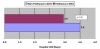
Adjusted least squares mean hospital length of stay by initial antibiotic regimen*. * The adjusted mean and p-value were derived from a least squares regression model that included PSI risk class, patient age, heart failure, chronic obstructive pulmonary disease, and admitting hospital as covariates.